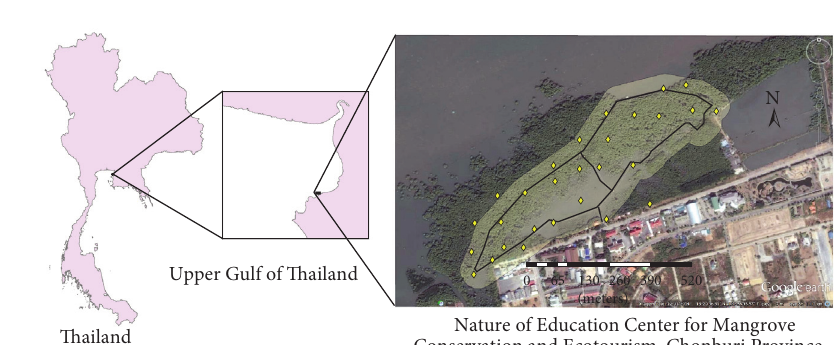
Figure 1: The Nature Education Center for Mangrove Conservation and Ecotourism located in coastal western Chonburi Province, Thailand.